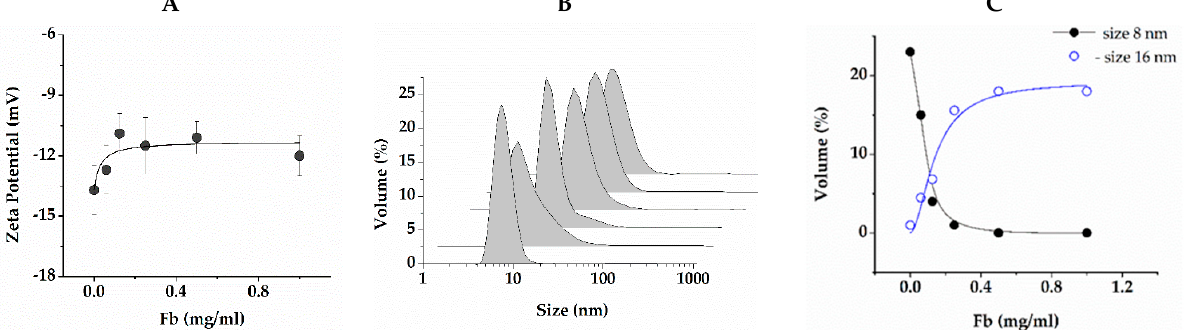
Figure 4. Dependence of zeta potential of RG at a concentration of 1 mg/mL ( A ), its hydrodynamic particle diameter ( B ) and proportion of particles with a size of 8 and 16 nm on concentration of Fb added ( C ). The solid line ( A ) is the approximation by formula y = B max × x/(k + x) with the following parameters: Z-potential at adsorption limit B max = − 11.59 ± 0.4 mV/mg and affinity constant k = 0.03 ± 0.01 mg/mL. Fibrinogen concentration ( B ): 0, 0.062, 0.125, 0.25, 0.5 and 1.0 mg/mL. Blue line on ( C ) is the approximation by the Hill equation: y = Vol max × xˆn/(kˆn + xˆn), with Vol max = 19.28 ± 1.97, k = 0.41 ± 0.08 mg/mL and n = 1.8 ± 0.4.